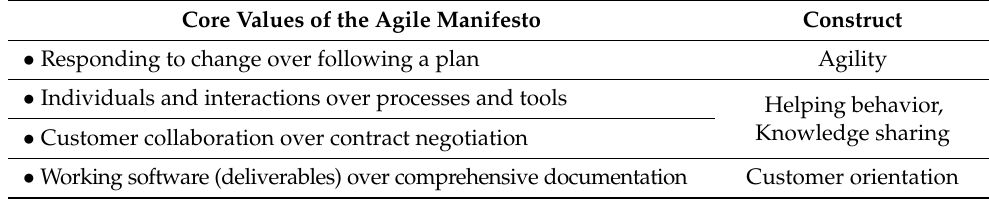
Table 1. Agile core values and similar concepts and